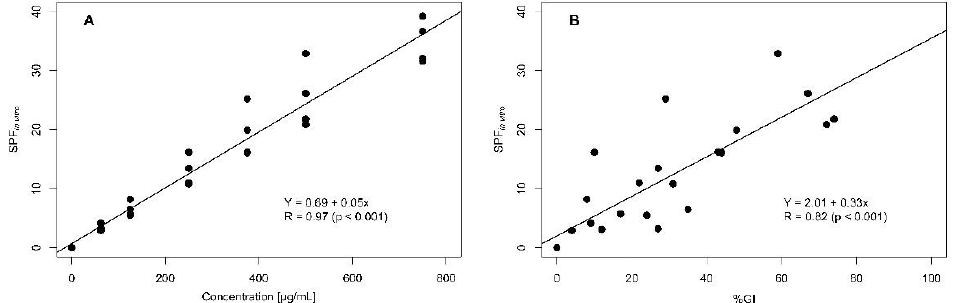
CNH: Colombian National Herbarium. The SPF in vitro values were classified in categories according to the European Commission recommendation as follows: no protection (0.0 ≤ SPF in vitro ≤ 5.9), low protection (6.0 ≤ SPF in vitro ≤ 14.9), medium protection (15.0 ≤ SPF in vitro ≤ 29.9), high protection (30.0 ≤ SPF in vitro ≤ 59.9), and very high protection (SPF in vitro ≥ 60.0). A λc > 370 nm defines broad-spectrum protection. The MDE values were previously indicated by Valbuena et al. [24], and these are as follows: type I (0.035 J/cm 2 = 350 J/m 2 ), type II (0.056 J/cm 2 = 560 J/m 2 ), type III (0.070 J/cm 2 = 700 J/m 2 ), and type IV (0.084 J/cm 2 = 840 J/m 2 ). † , For the comparison, a widely used commercial sunscreen (Eau Thermale Av è ne SPF 50+) and sunscreen ingredient (titanium dioxide) were included. ‡ , The higher sunscreen concentration ( v / v ) evaluated was 30 mg/mL, dissolved in distilled water.